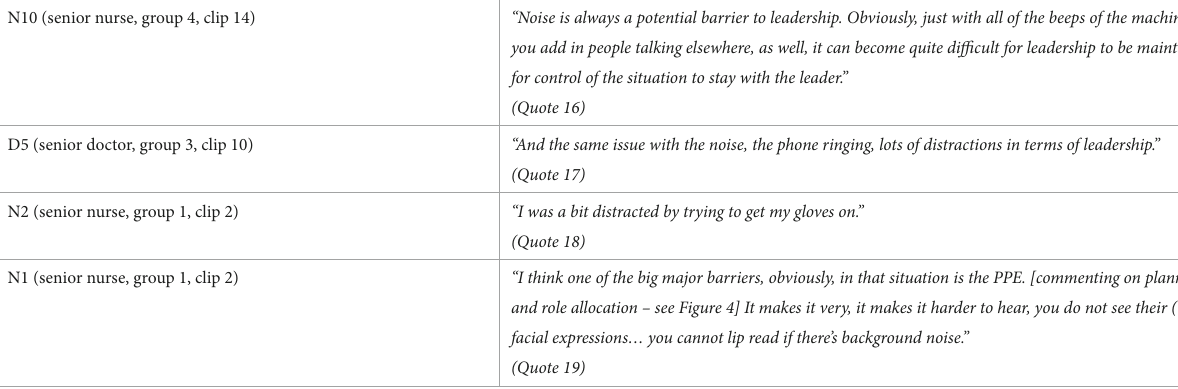
TABLE 7 Illustrative quotes (barriers to leadership). N10 (senior nurse, group 4, clip